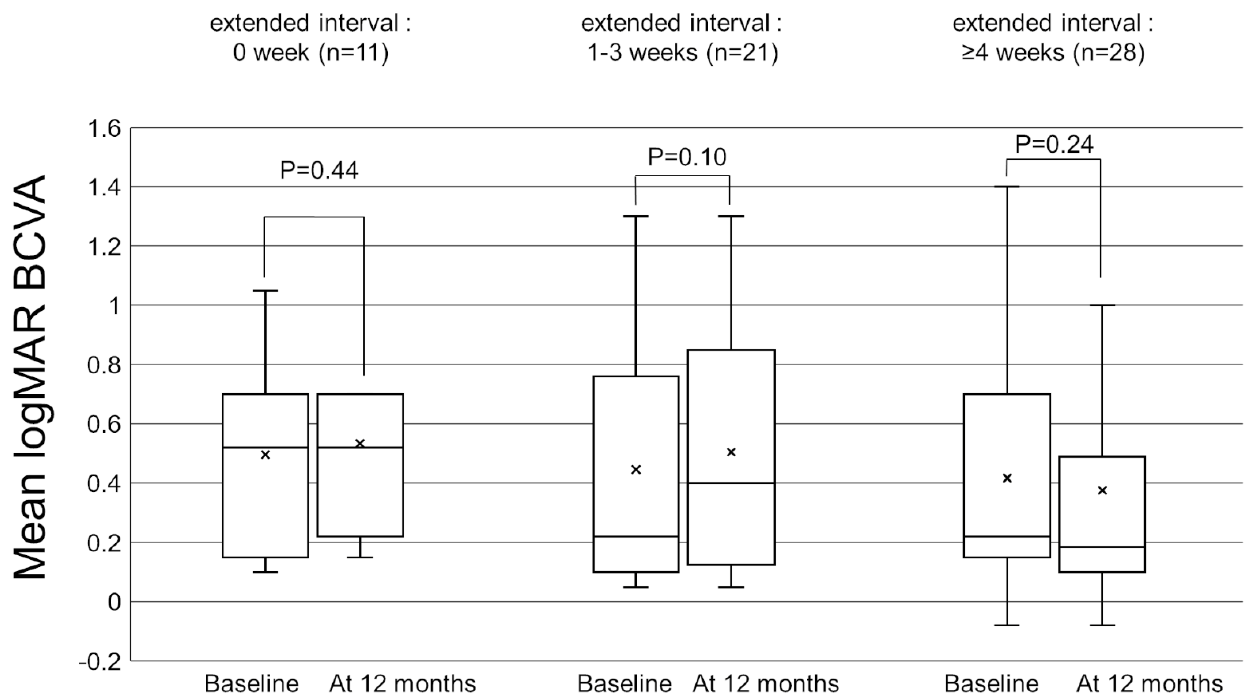
Figure 2. Box-and-whisker plot of mean and median best-corrected visual acuity (BCVA) before and after switching to brolucizumab according to the extended treatment intervals. The “x” marks in the boxes indicate the mean BCVA. The horizontal lines in the boxes indicate the median BCVA, and the top/bottom edges of the boxes indicate the 25/75 percentile. The top/bottom edges of the whiskers indicate maximum/minimum values. ( Left ) The mean change of BCVA in the patients with extended intervals of 0 weeks. ( Middle ) The mean change of BCVA in the patients with extended intervals of 1–3 weeks. ( Right ) The mean change of BCVA in the patients with extended interval of ≥ 4 weeks.